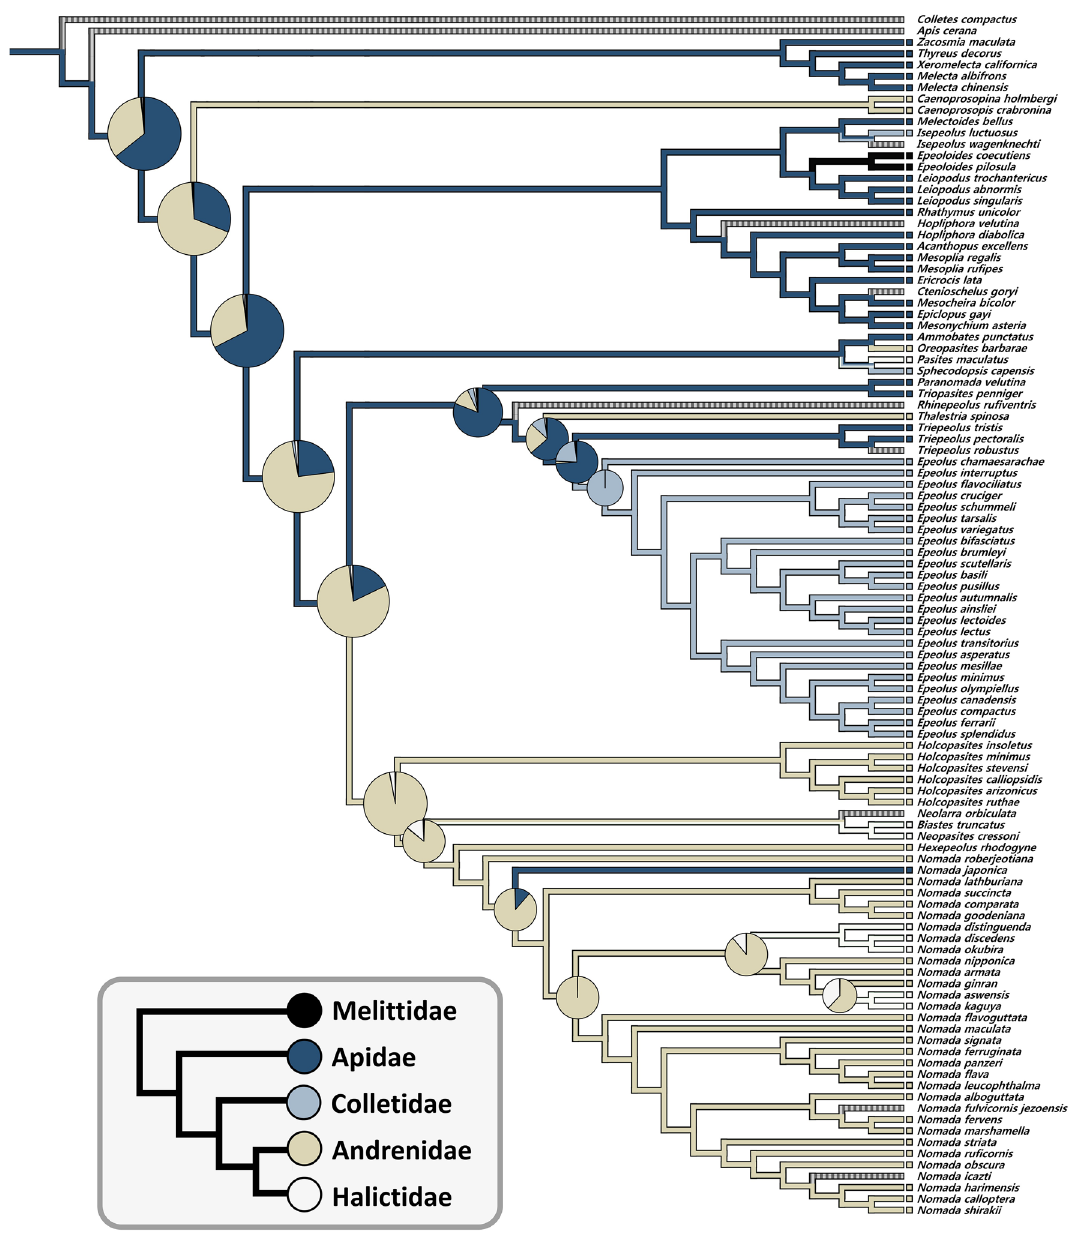
Figure 2. Ancestral state reconstruction of nomadine host associations at the family-level. Produced using the Bayesian analysis. The pie charts represent mean posterior probabilities assessed under RJ-MCMC analysis using Bayestraits. Branch colors indicate the result of parsimony ancestral state reconstruction performed by Mesquite (Black: Melittidae; Navy: Apidae; Sky blue: Colletidae; Ivory: Andrenidae; White: Halictidae; Mixed black/white lines: outgroups or unknown